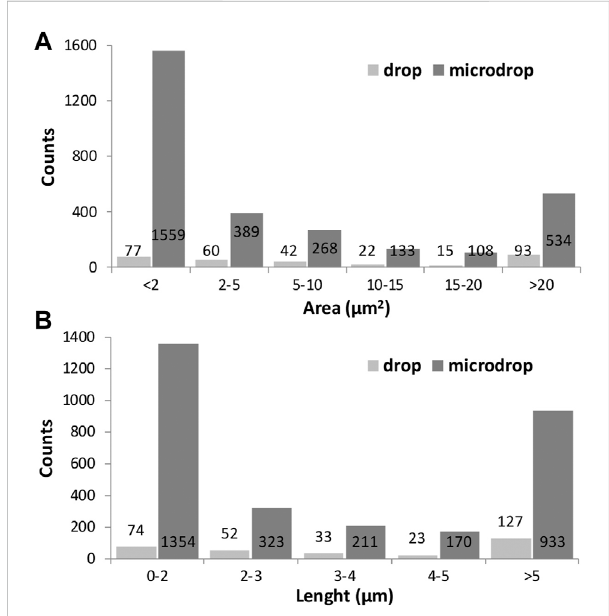
FIGURE 7 Histograms showingthesize distribution oftheidenti fi edobjects represented by their area in µm 2 (A) and their maximum length in µm (B) for drop and microdrop depositions, respectively. Counts are normalised to mm 2